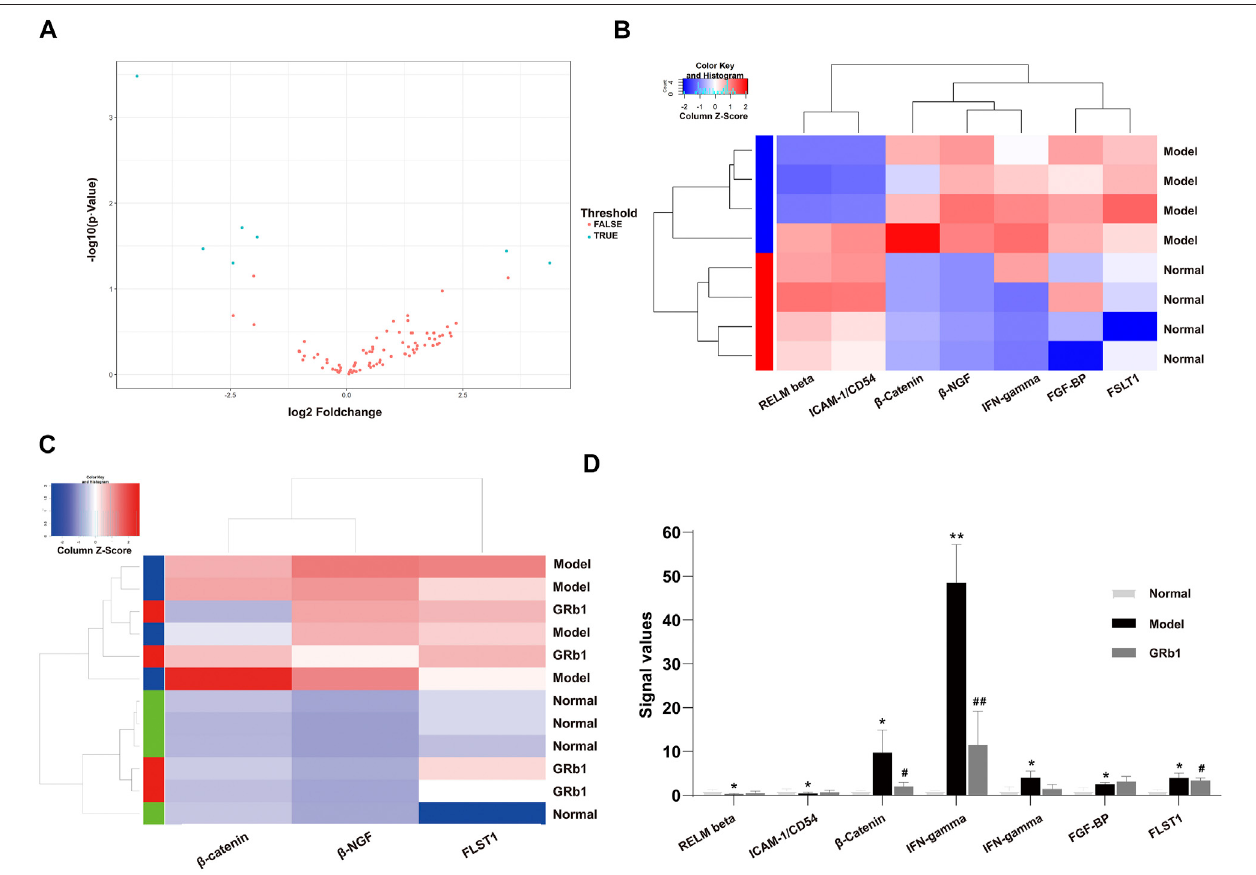
FIGURE3| Identi fi cationofdifferentialexpression proteins(DEPs)inGPLmodelratsusingantibodyarrayassayandtheeffectsofGRb1onDEPs. (A) Volcanoplot indicating the distribution of all proteins between the normal and model groups. (B) Heatmap representation showing the seven DEPs between the normal and model groups, in which 5 DEPs were signi fi cantly up-regulated, while two DEPs were signi fi cantly down-regulated. (C) Heatmap representation indicating the three DEPs among the three groups (normal, model and GRb1 groups). (D) Histograms showing signal values of the three DEPs among the three groups (normal, model